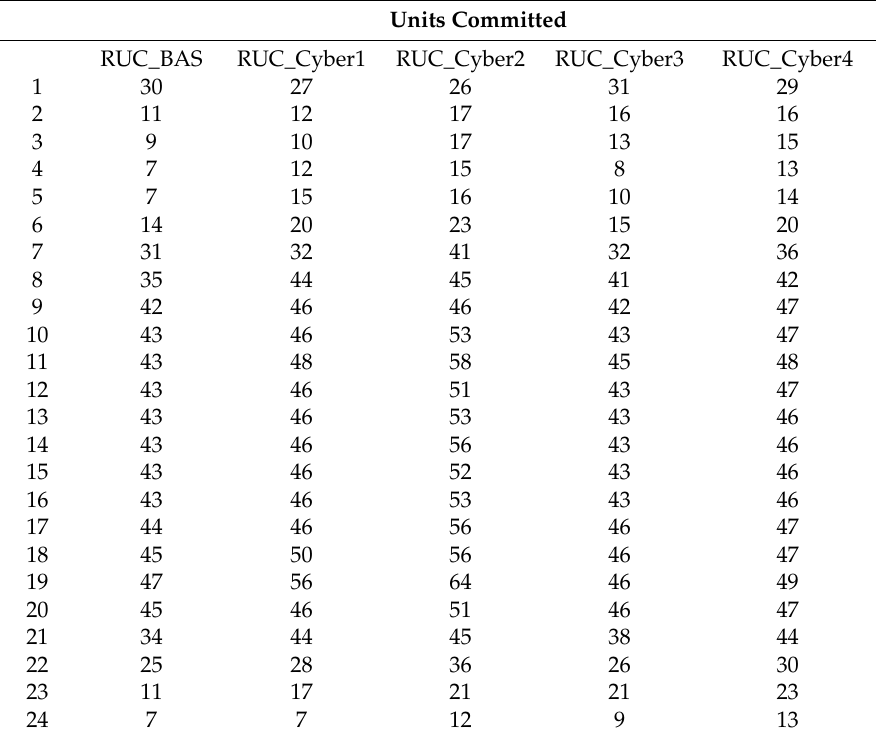
Table 2. Number of thermal units dispatched for different scenarios using the RUC